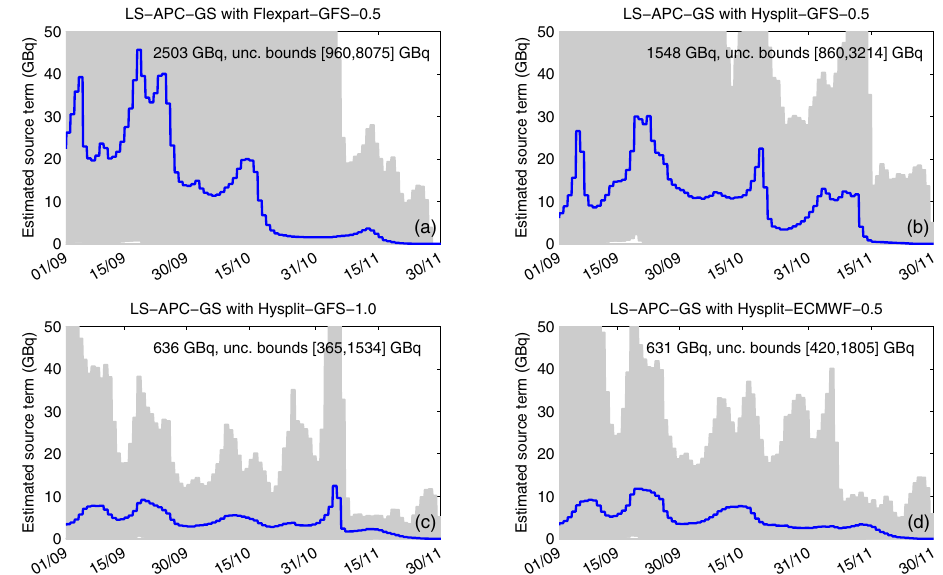
Figure 5. Estimated source terms at locations selected by the marginal likelihood method, shown in Fig. 2, using the LS-APC-GS algorithm for all four tested combinations of dispersion models and meteorological data: Flexpart-GFS-0.5 (a) , Hysplit-GFS-0.5 (b) , Hysplit-GFS- 1.0 (c) , and Hysplit-ECMWF-0.5 (d) . The estimated source terms are accompanied by the 95% uncertainty regions (gray filled regions). The estimated activity for the whole period is reported inside each plot with its associated uncertainty bounds.